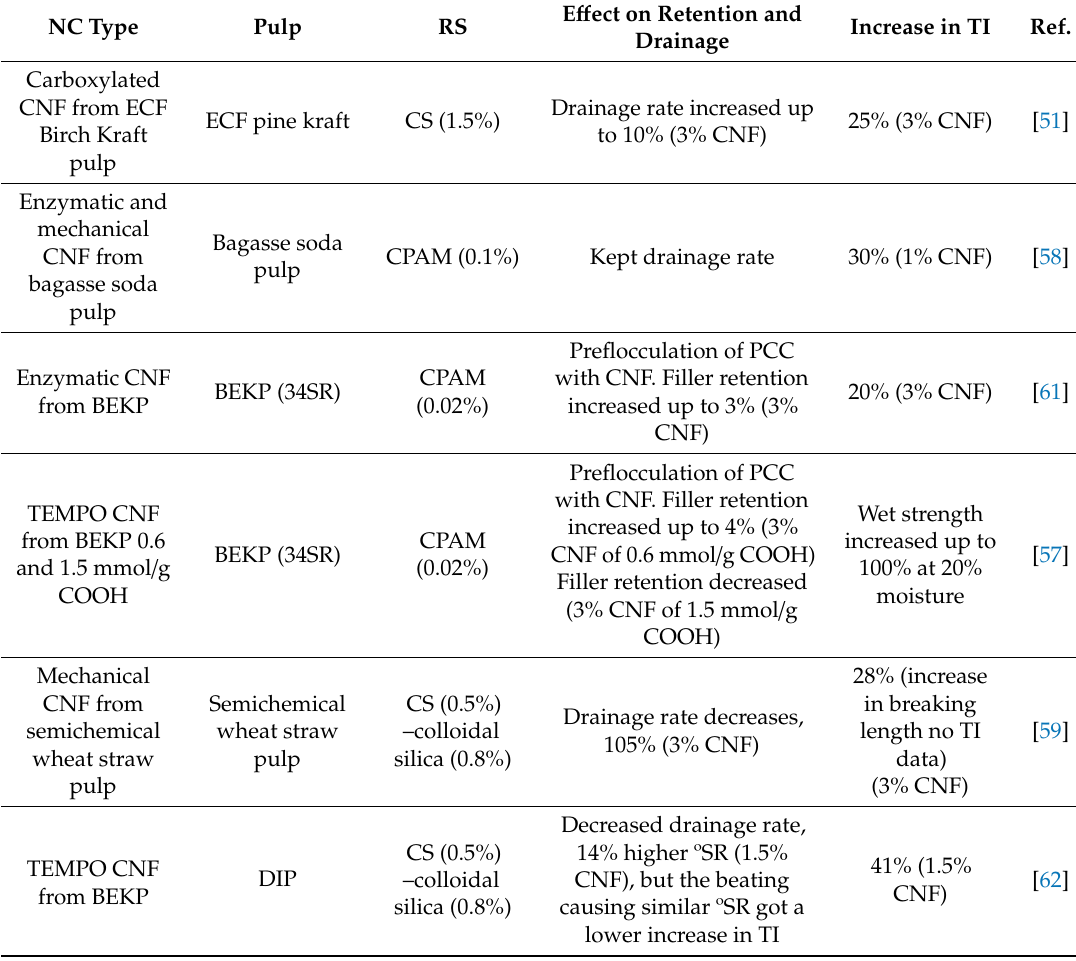
Table 1. Synergies between retention systems and NC (e ff ects on retention and drainage with respect to the pulp with RS but without